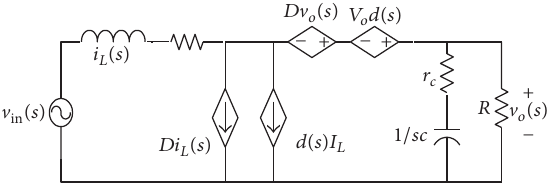
Figure 3: Boost circuit CCM average switching model. Figure 4: Boost circuit CCM small signal